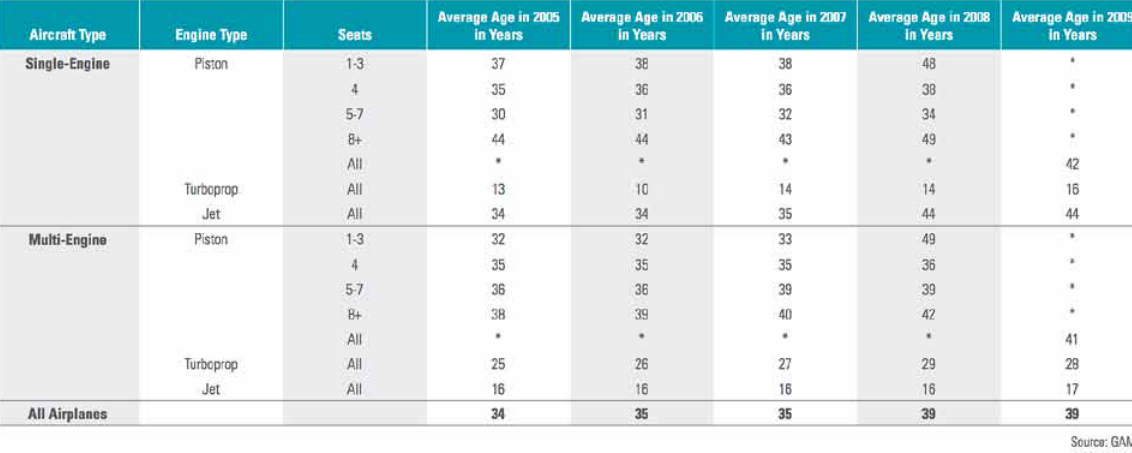
Fig. 4. Average service year of North American fleets. From (GAMA